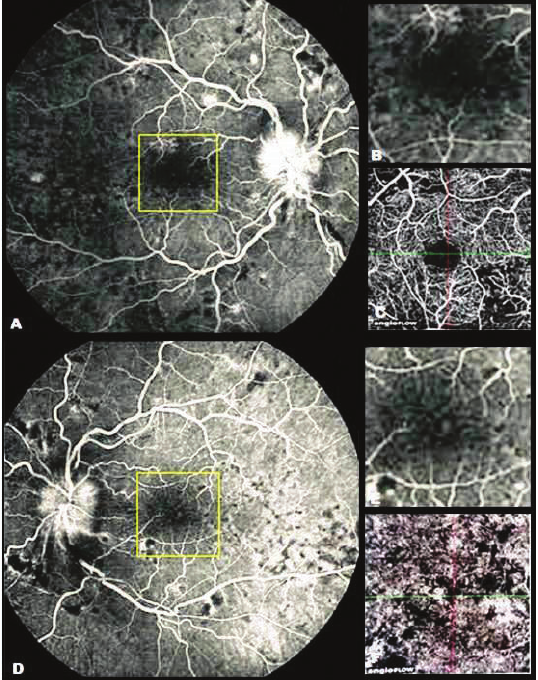
Figure 3. (A) Late phase of fluorescein angiography (FA) of the right eye. (B) The magnified view of the yellow square. (C) OCTA (superficial layer) of the same location of the yellow square; the ischemic areas and the alternation of capillary vessels are obviously observed, however, in the FA these changes are hardly visible. (D) Late phase of the FA of the left eye. (E) The magnified view of the yellow square. (F) OCTA (choriocapillaris layer) of the same location of the yellow square, the ischemic areas and the Elschnig spots are prominently observed, however, in the FA these changes are hardly